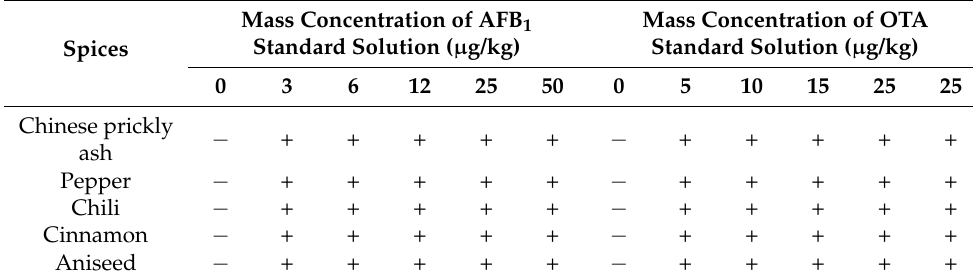
Table 2. Detection limit of test